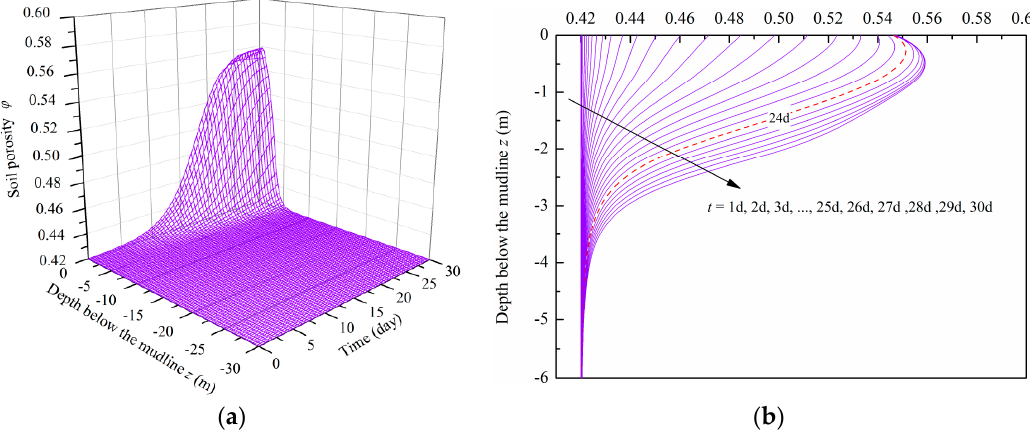
Figure 6. Variations of the concentration of moving particles with the increase of wave acting time: ( a ) Diagram of three-dimensions; ( b ) diagram of two-dimensions.